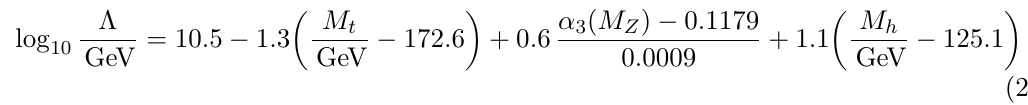
are plotted as t as dot-dashed h